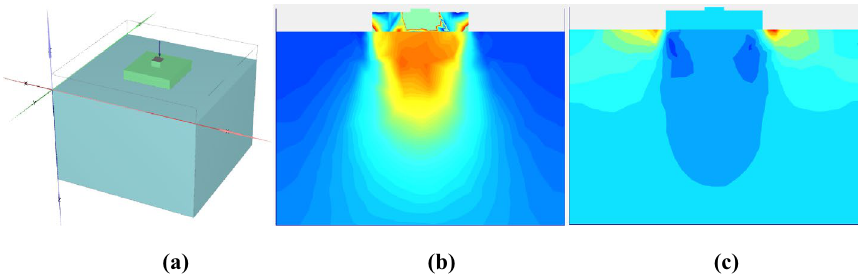
Fig. 8 Plaxis 3D results for the sandbox ( a ) overview, ( b ) stress, and ( c ) strain